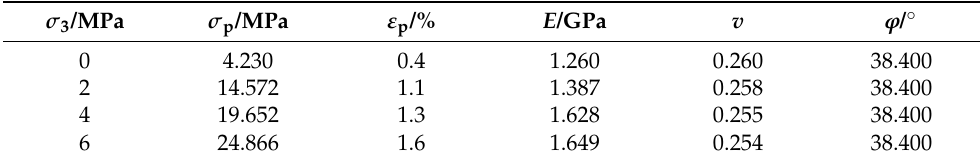
Table 1. Mechanical parameters of red sandstone without freeze-thaw cycle.